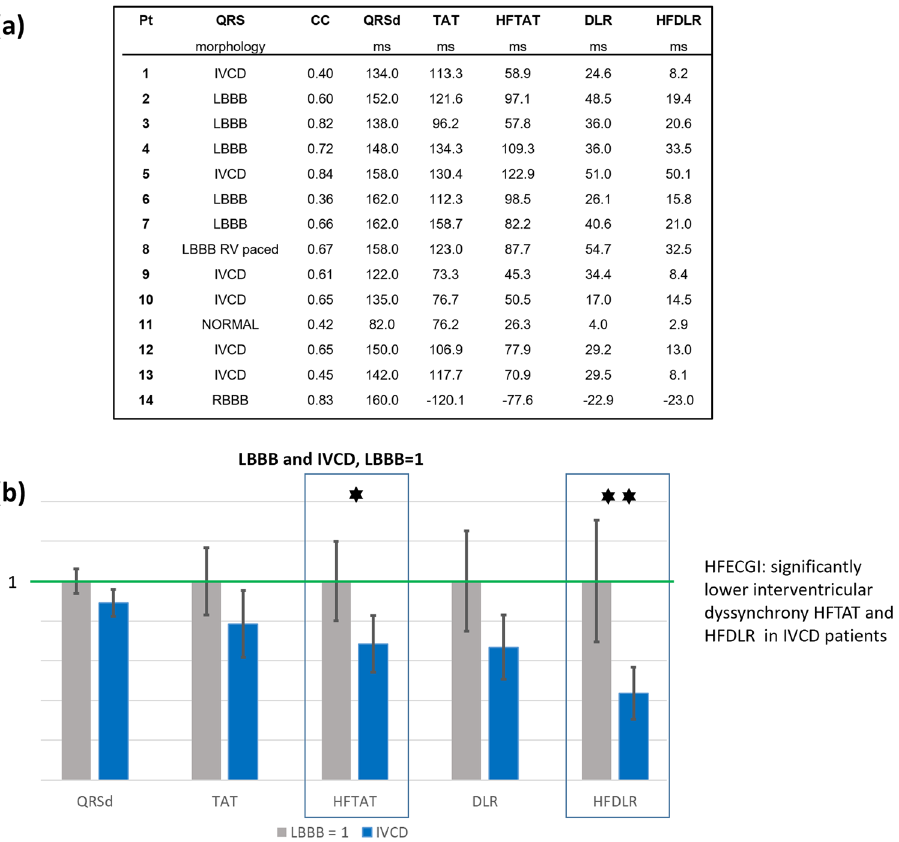
Figure 4. ECGI and HFECGI parameters in LBBB, IVCD, RBBB and normal patients. ( a ) Pt—patient, CC— correlation coefficient between EAT and HFAT in virtual points, QRSd—QRS duration, TAT, HFTAT—total activation time, DLR, HFDLR—interventricular electrical delay. ( b ) Relative magnitudes of parameters in IVCD patients compared to LBBB patients (mean LBBB = 1), *p < 0.05, **p < 0.01. HFECGI parameters HFTAT and HFDLR indicate significantly lower dyssynchrony in IVCD patients. Mean values and standard